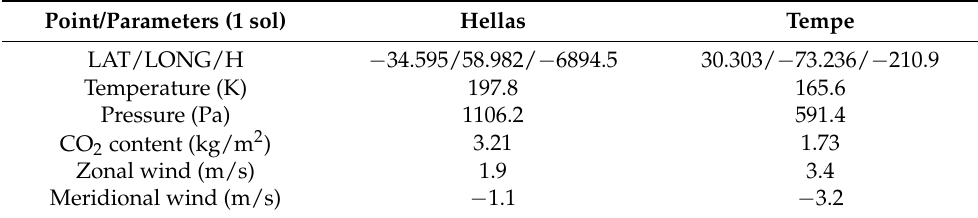
Table 2. Parameters for selected points.